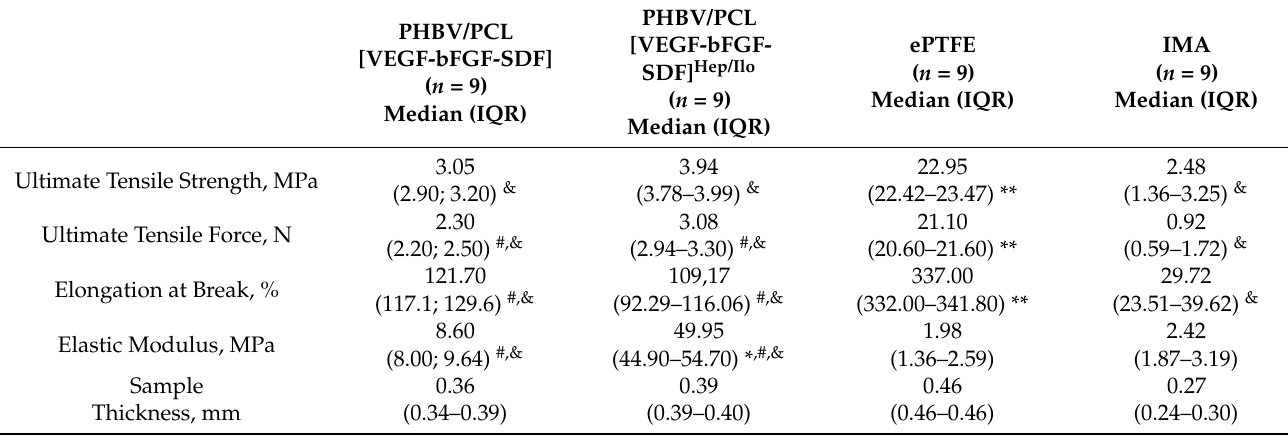
Table 2. Mechanical properties of PHBV/PCL[VEGF-bFGF-SDF] vascular grafts before and after Hep/Ilo coating in comparison with ePTFE prostheses and